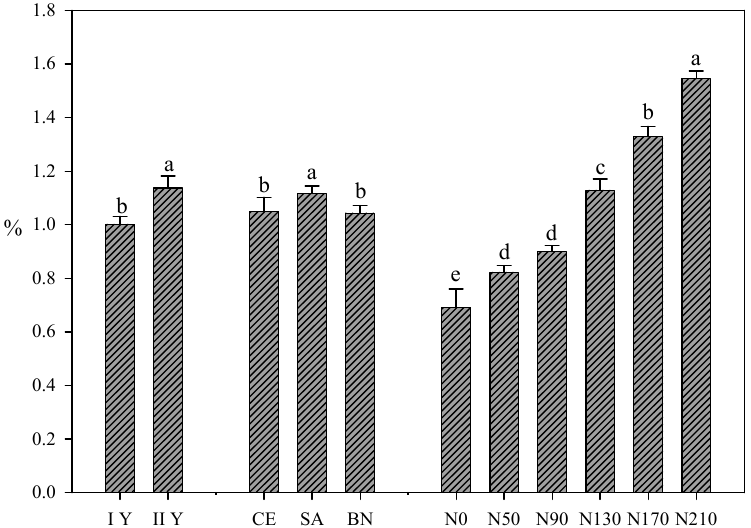
Figure 4. The effect of Years, Locations, and N fertilization rates (N0, N50, N90, N130, N170, and N210) on alkaloids content (% d.w .) of cured leaves. Different letters indicate significant differences according to Duncan’s test ( p < 0.05); d.w., dry weight.